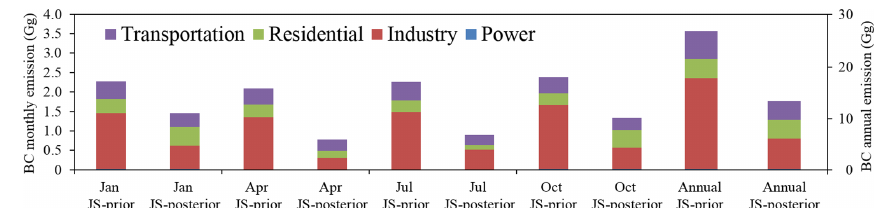
Figure 2. The monthly (left axis) and annual (right axis) emissions by sector for southern Jiangsu 2015 in JS-prior and JS-posterior (unit: